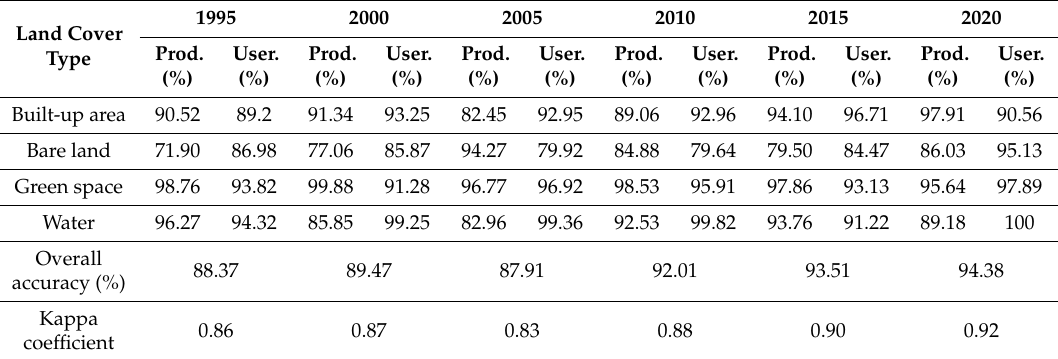
Figure 2. Land cover classification map in the study area for six time periods from 1995 to 2020. Table 3. Accuracy of classified land cover